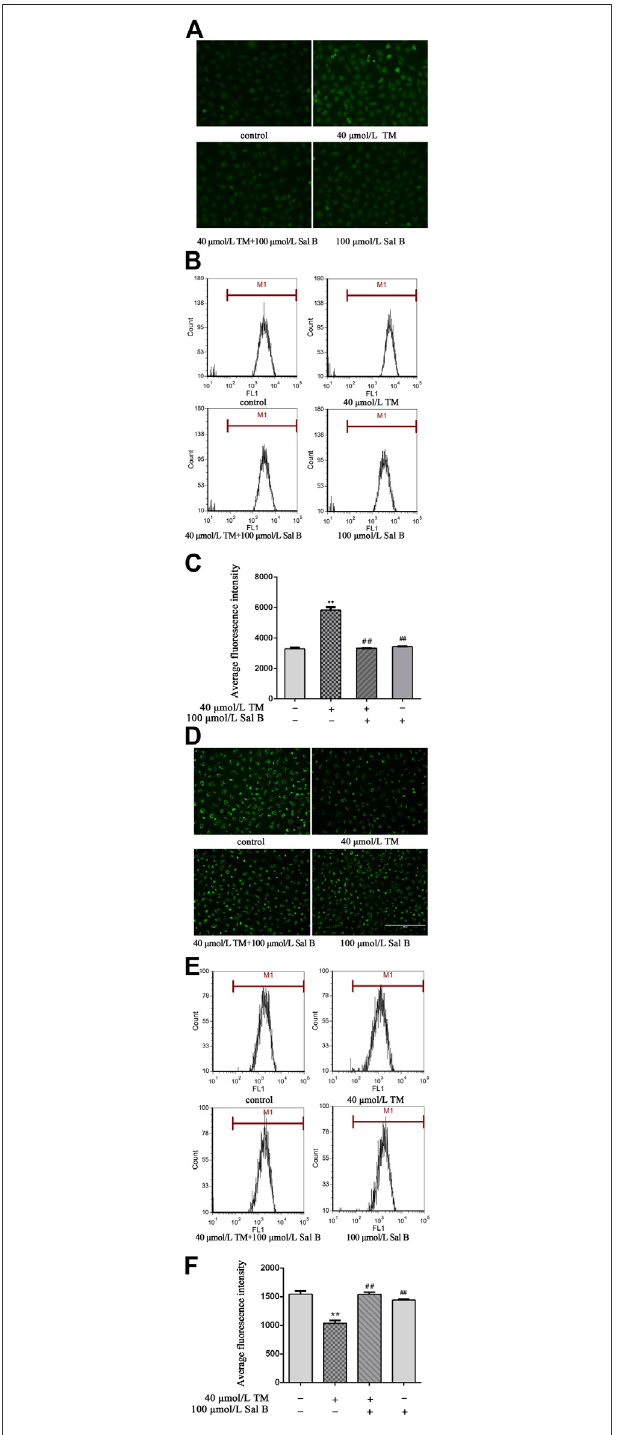
FIGURE 8 | Effect of Sal B on TM-treated cells induced the ROS generationandlossoftheMMP. (A) Thegreen fl uorescenceintheTM-treated cells was higher than in the control cells. However, Sal B could reduce the fl uorescence intensity. (B, C) Similar results were obtained by fl ow cytometry. (D) The green fl uorescence in the TM-treated cells was lower than in thecontrol cells. Sal Btreatment increased the fl uorescence intensity. (E, F)